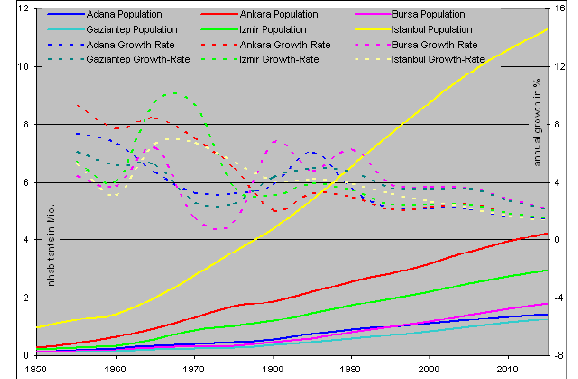
Figure 17: Annual growth-rates of Turkish agglomerations, based on Data of the World Urbanisation Prospects - Revision 2003